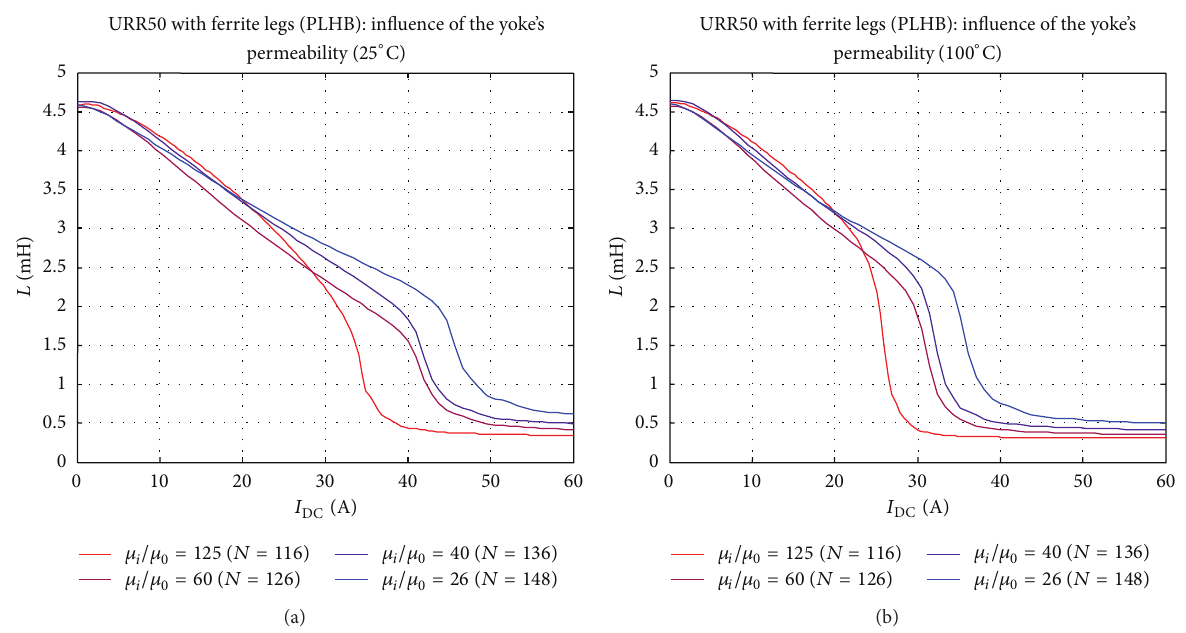
Figure 8: Parameter study: inductance curves at 25 ∘ C (a) and 100 ∘ C (b) using Sendust (CoolM 𝜇 ) yokes of different permeability grades.